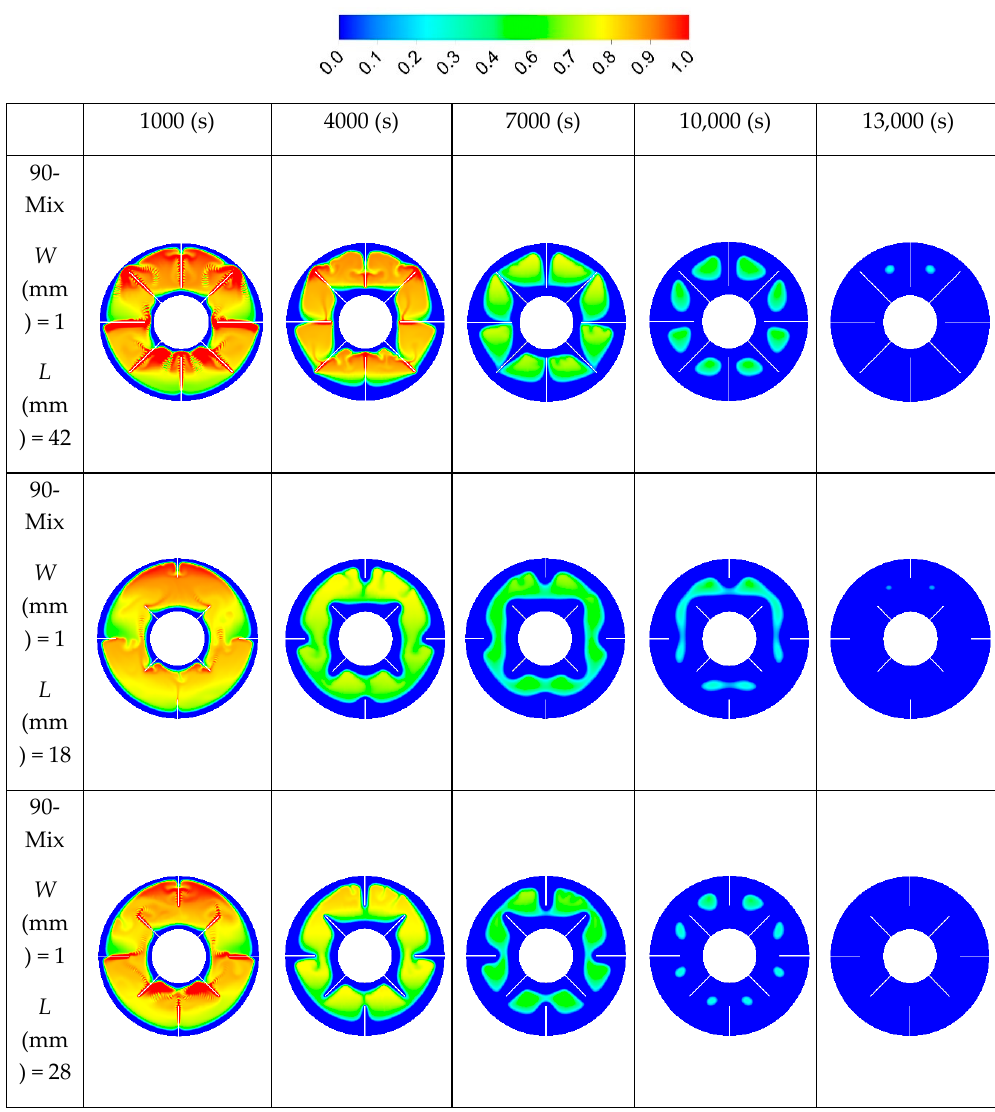
Figure 6. The effect of fins dimensions on the temperature distribution.